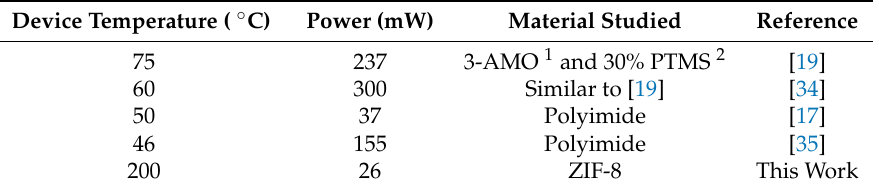
Table 2. Comparison of power consumption and operating temperature of MEMS capacitor sensors with integrated microhotplate.